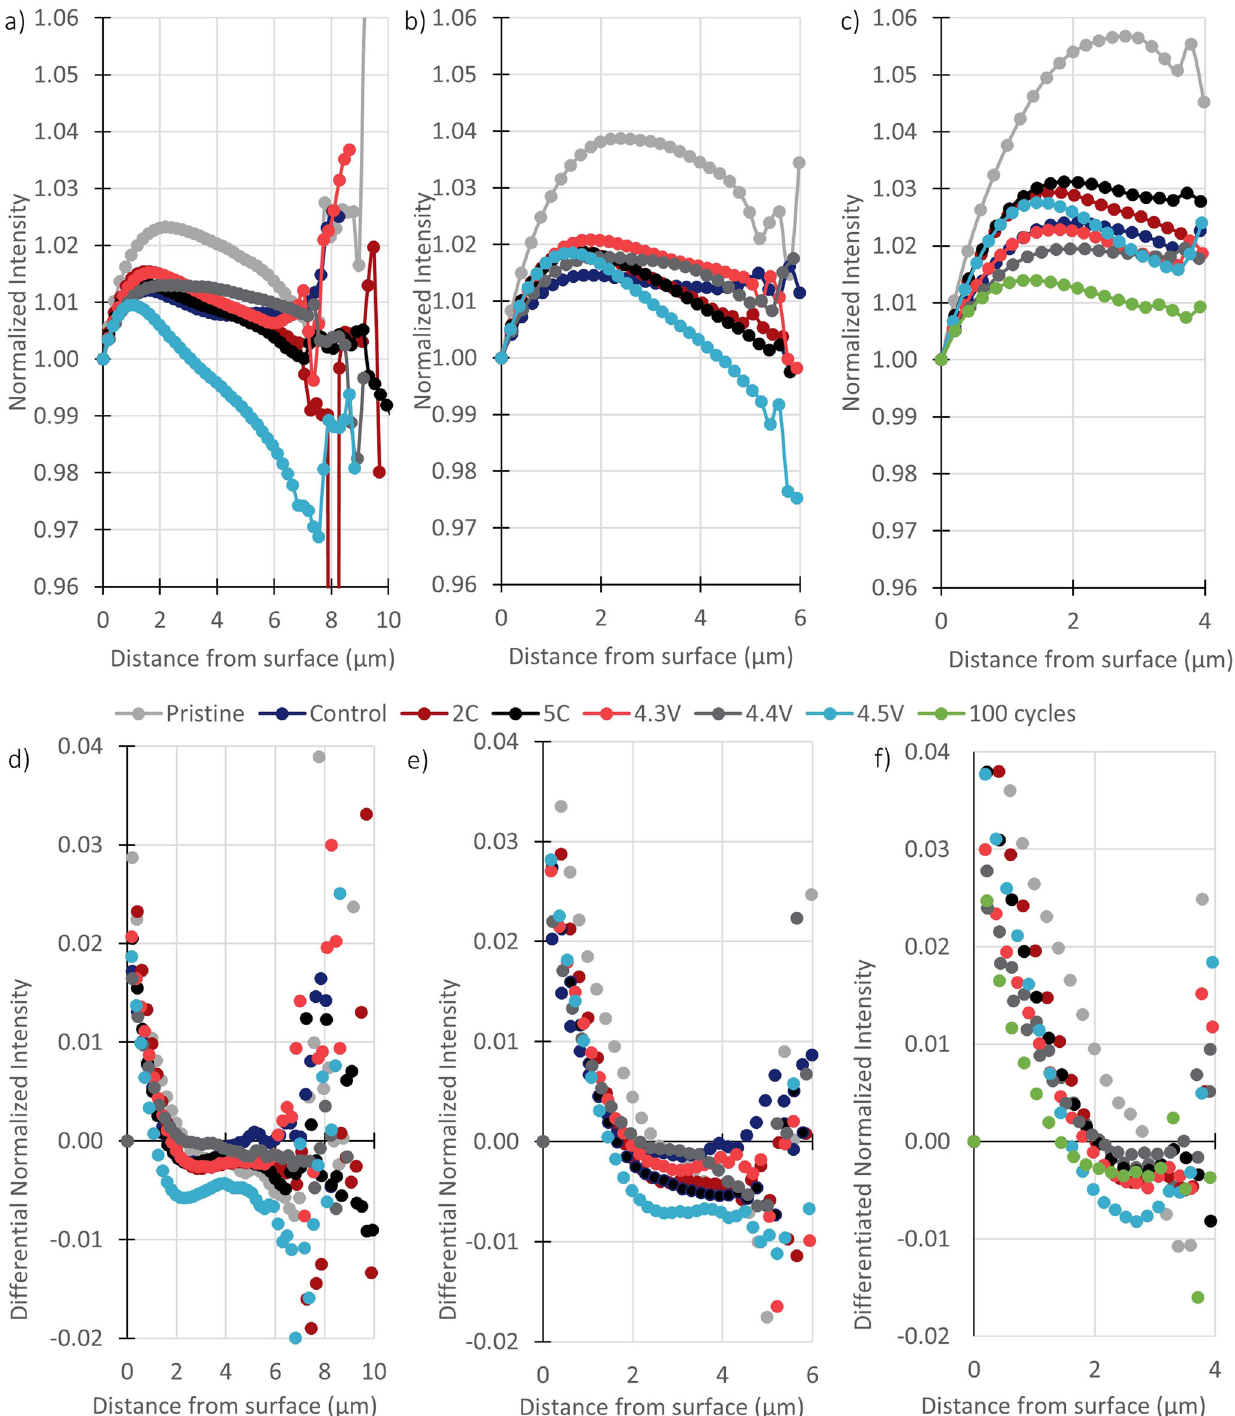
Fig. 6 GREAT results for different particle sizes. Normalized intensity values for a particles larger than 7 µm, b particles between 5 and 6 µm, and c between 3.5 and 4.0 µm. Differential normalized intensity values for d particles larger than 7 µm, e particles between 5 and 6 µm, and f between 3.5 and 4.0 considering all particles. As seen previously, high voltage or C-rate sizes, and larger or smaller than 5 µm. The values for the under has a signi fi cant effect on the largest particles, with 4.5 V and 5C segmented case are also included, to show the robustness of this fi nal method. Pristine samples have the highest values for all size displaying the lowest values. For the smaller particles, once again the 100 cycled cell has the lowest values, followed the 4.4 V. Smaller ranges, as is expected, and this is the case for under segmented particles are once again seen to be more robust against particles with one exception. The three cells that experience the microstructural defect formation, yielding higher values. largest capacity fades also have the lowest core intensities when